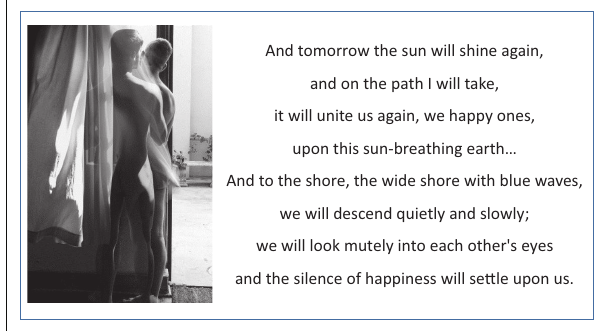
FIGURE 4: Morgen : ‘The